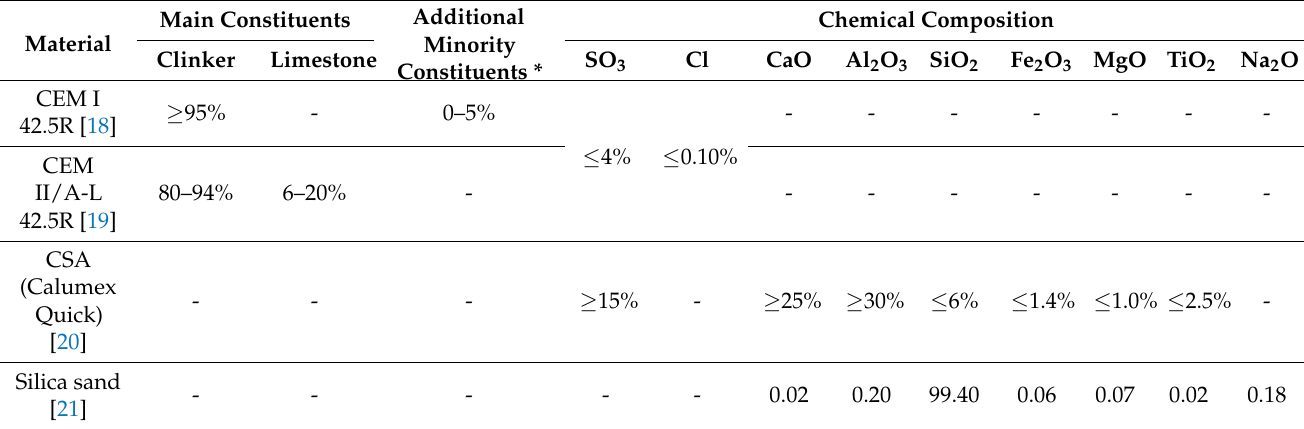
Table 1. Chemical properties of Portland cement, CSA cement and siliceous sand.